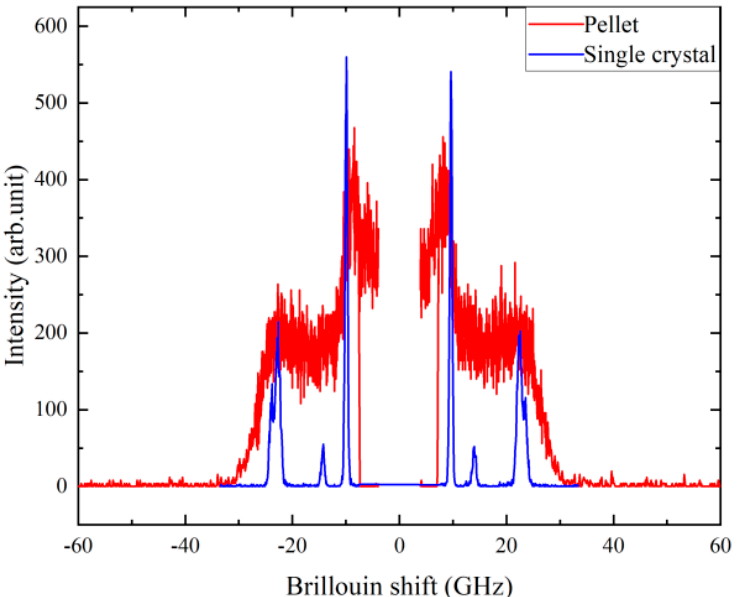
Figure 7. Comparison of the Brillouin spectrum of taurine pellet and single-crystal samples measured at room temperature.